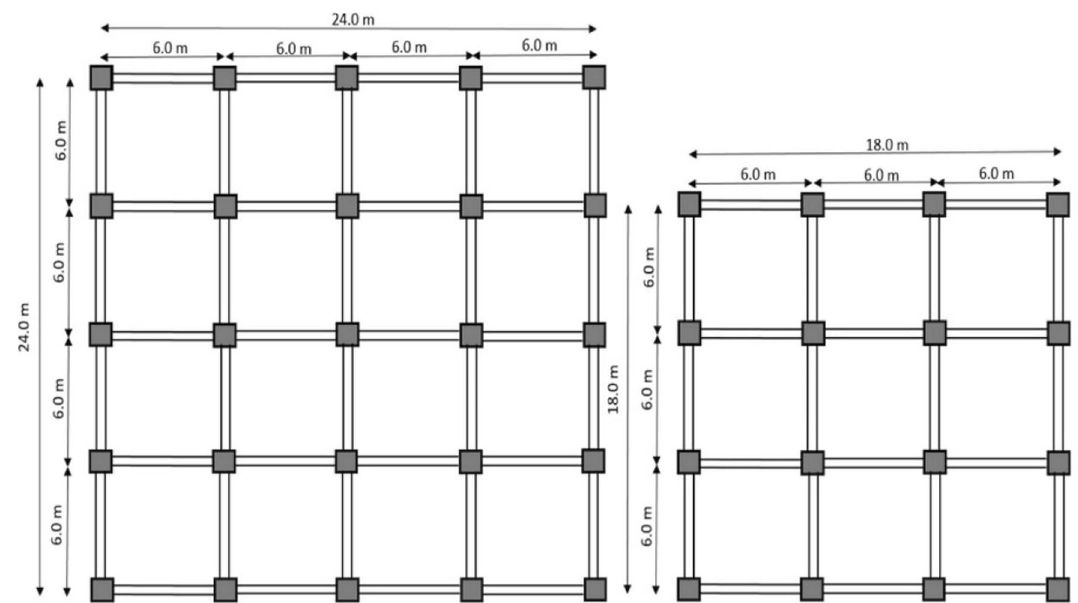
Fig. 1 Planar layout for the 5-story reinforced concrete (RC) frame structures (left), and the 7-story and 10-story RC frame structures (right) in Bucharest, Romania